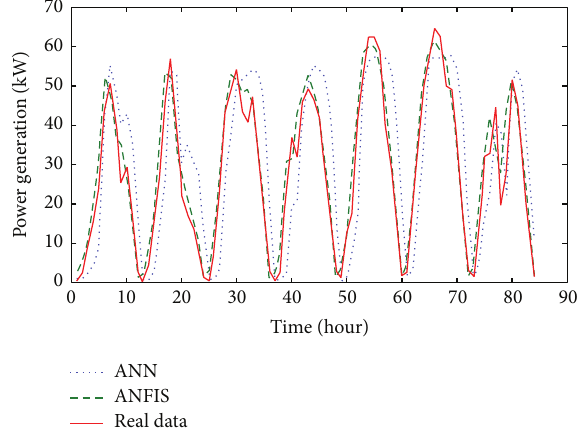
Figure 8: Forecasting results for PV power at NPU by using ANN and ANFIS.